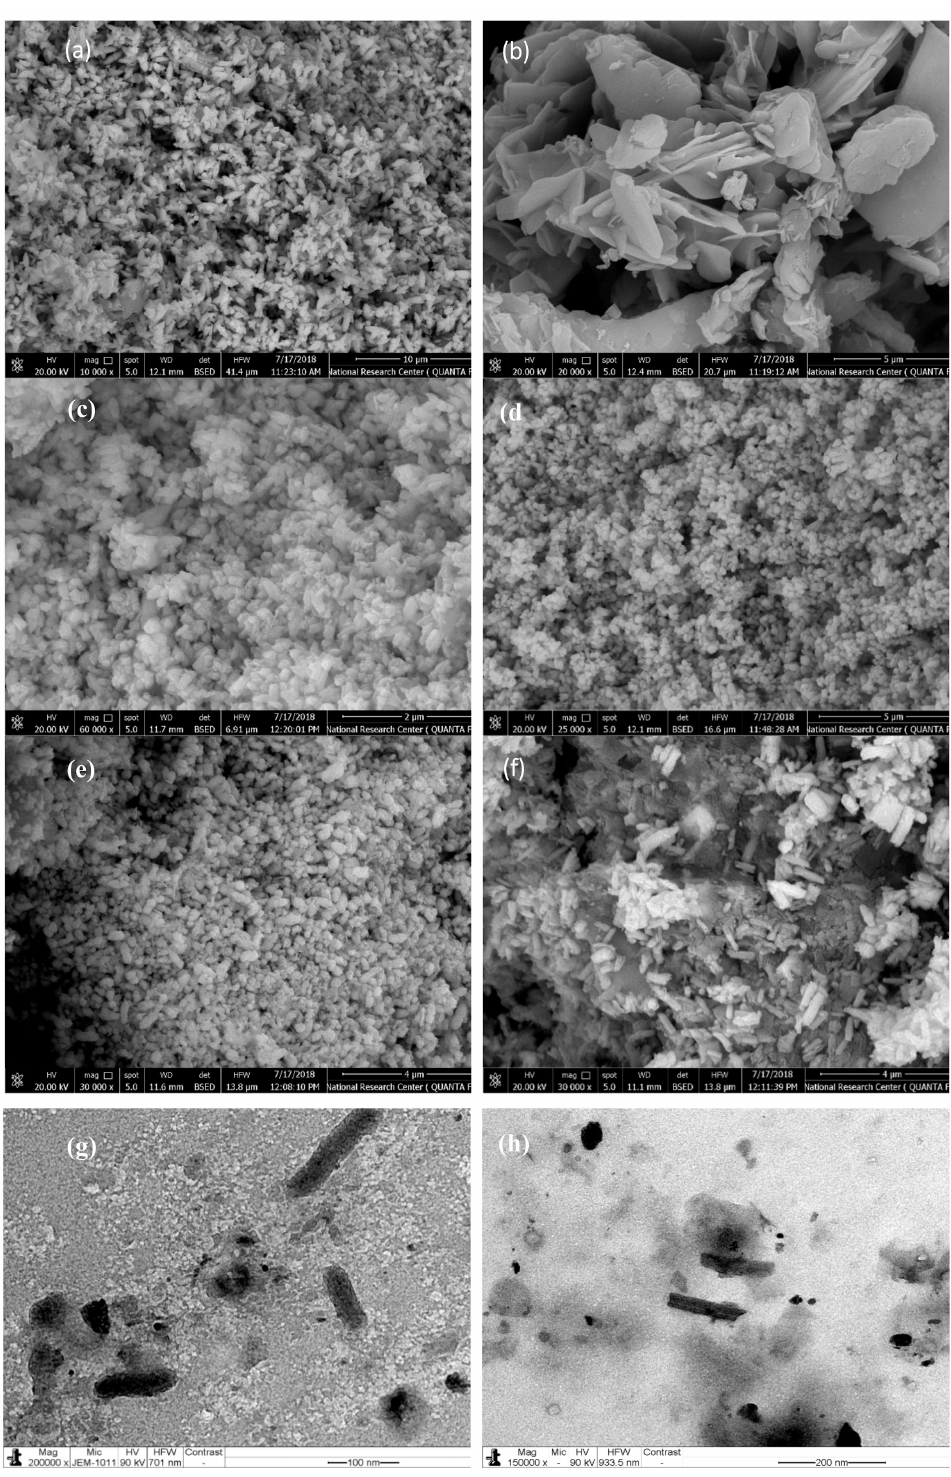
Figure 2. FE-SEM images of ZnO samples prepared under di ff erent conditions: ( a ) C = 0.1 M, pH = 9, T = 150 ◦ C, and t = 1.5 h; ( b ) C = 0.5 M, pH = 9, T = 150 ◦ C, and t = 1.5 h; ( c ) C = 0.3 M, pH = 11, T = 150 ◦ C, and t = 1.5 h; ( d ) C = 0.3M, pH = 9, T = 50 ◦ C, and t = 1.5 h; ( e ) C = 0.3 M, pH = 9, T = 150 ◦ C, and t = 1.5 h; ( f ) C = 0.3 M, pH = 7, T = 150 ◦ C, and t = 1.5 h. ( g ) TEM images of ZnO sample prepared under the conditions of C = 0.3 M, pH = 9, T = 150 ◦ C, and t = 1.5 h; ( h ) TEM images of ZnO sample prepared under the conditions of C = 0.3 M, pH = 9, T = 150 ◦ C, and t = 1.5